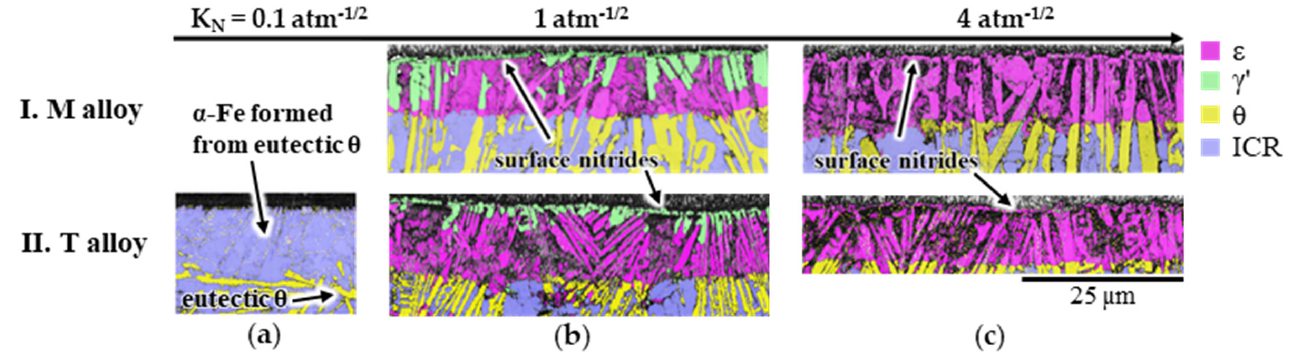
Figure 3. Cross-sectional EBSD phase maps of the compound layers of white-solidified ( I ) M-3.5C-3Si model alloy [8] and ( II ) commercially available ferritic cast iron T-2.5Si-0.2Mn-0.1Cu [31] nitrided at 540 °C for 16 h with ( a ) K N = 0.1 atm − 1/2 , ( b ) K N = 1 atm − 1/2 , and ( c ) K N = 4 atm − 1/2 .